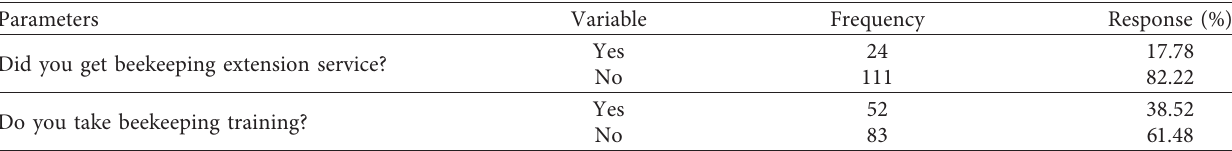
Table 12: Beekeeping extension and training in the study